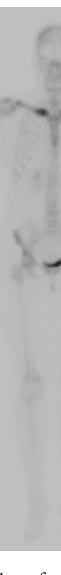
Figure 3: Frontal projection from a bone scan shows increased tracer uptake in the medial right clavicle, consistent with either metastatic disease or osteomyelitis. Biopsy confirmed metastatic pancreatic